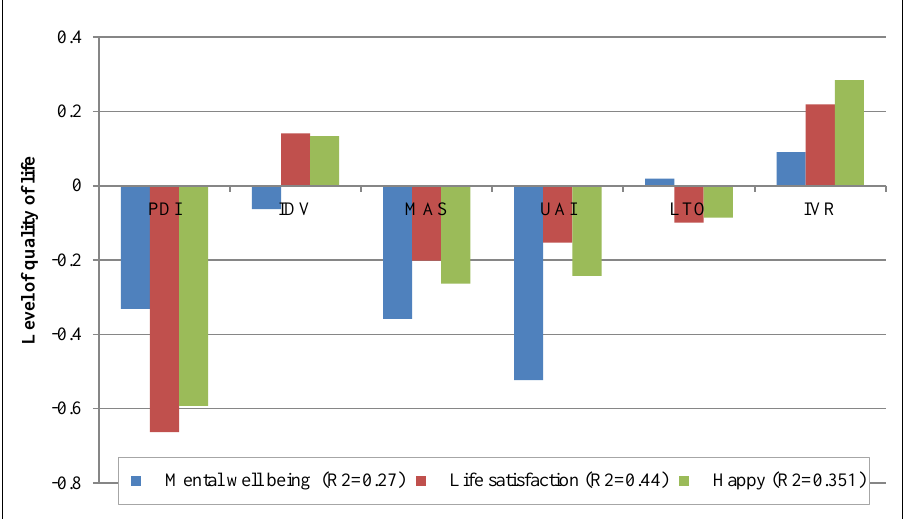
Figure 3. Quality of